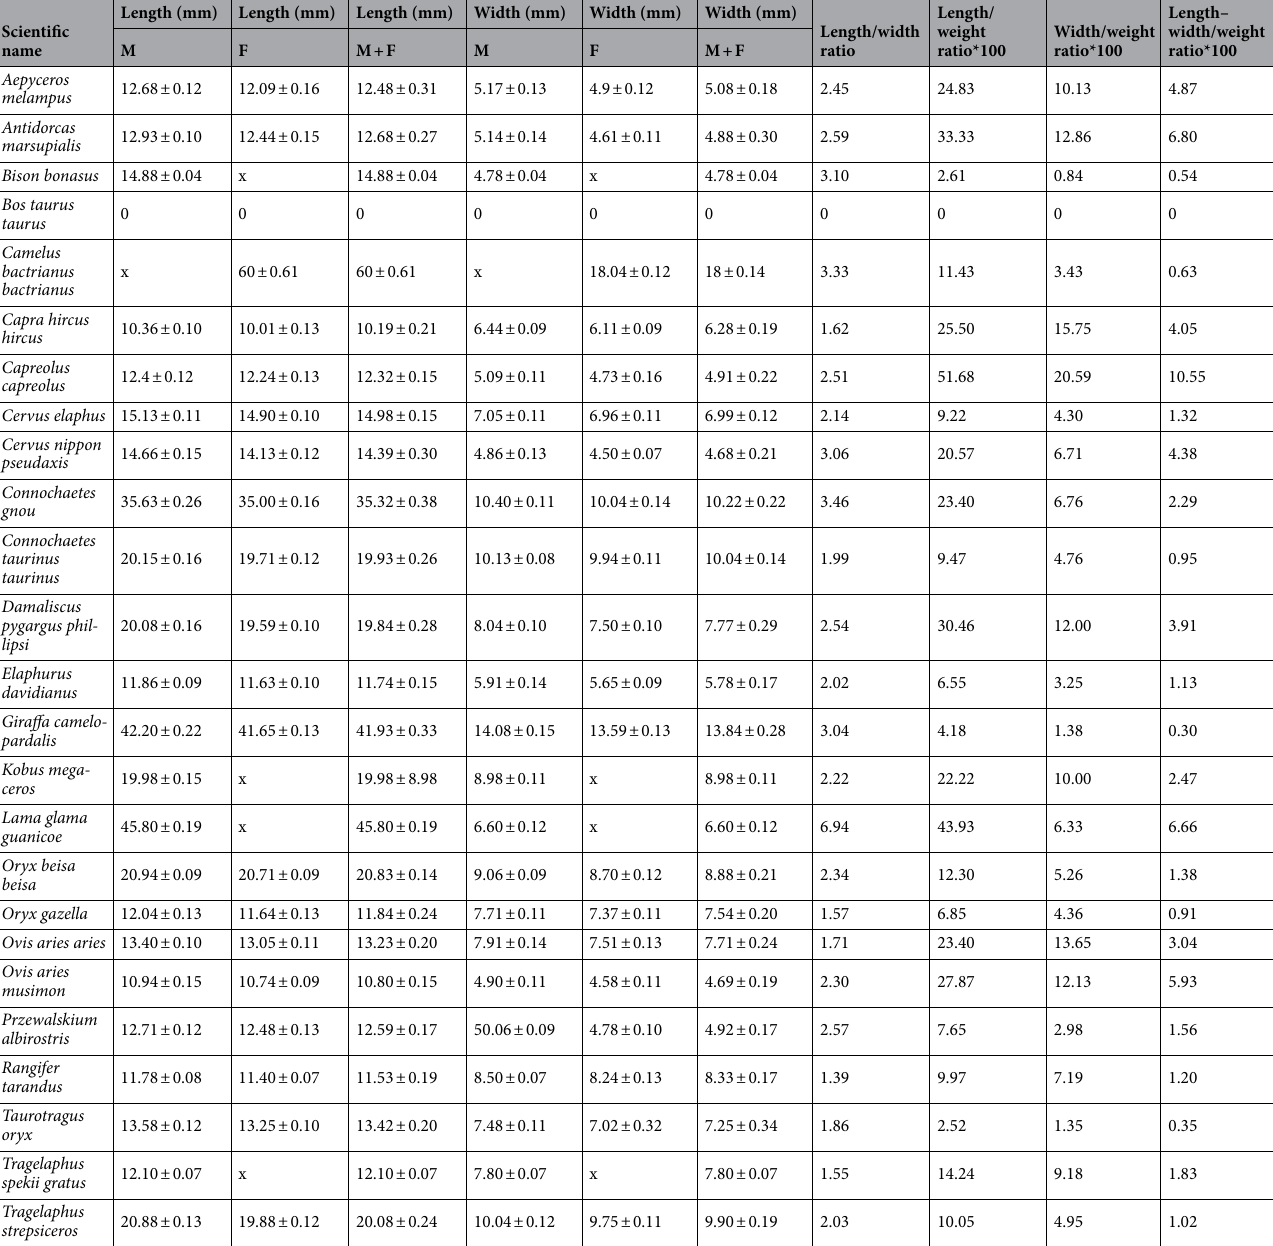
Table 1. Average dimensions (± standard deviation) of the oval opening in the manica flexoria (OWMF) and their ratios (using M + F values) in the inspected species. F female, M male, x not